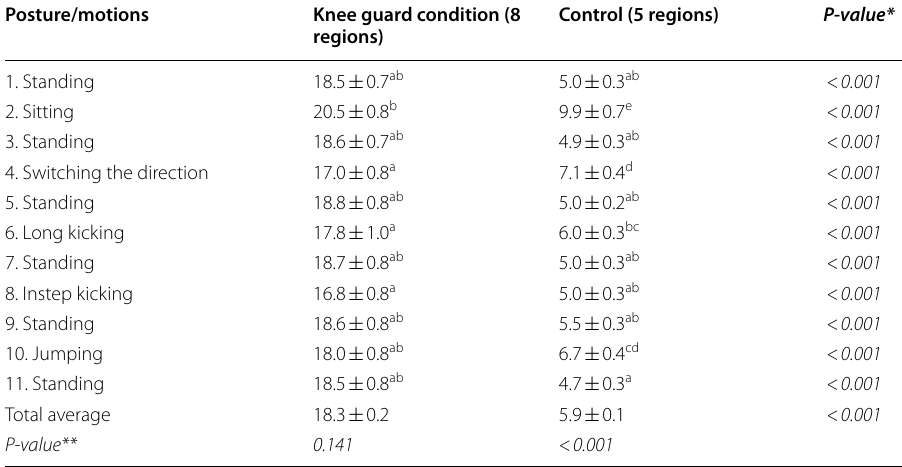
N 21; *Differences between two conditions; **Differences between the 11 postures. The upper cases of a,b,c,d,e represent = statistically identified groups classified by Duncan test among the 11 motions. Data are expressed as mean